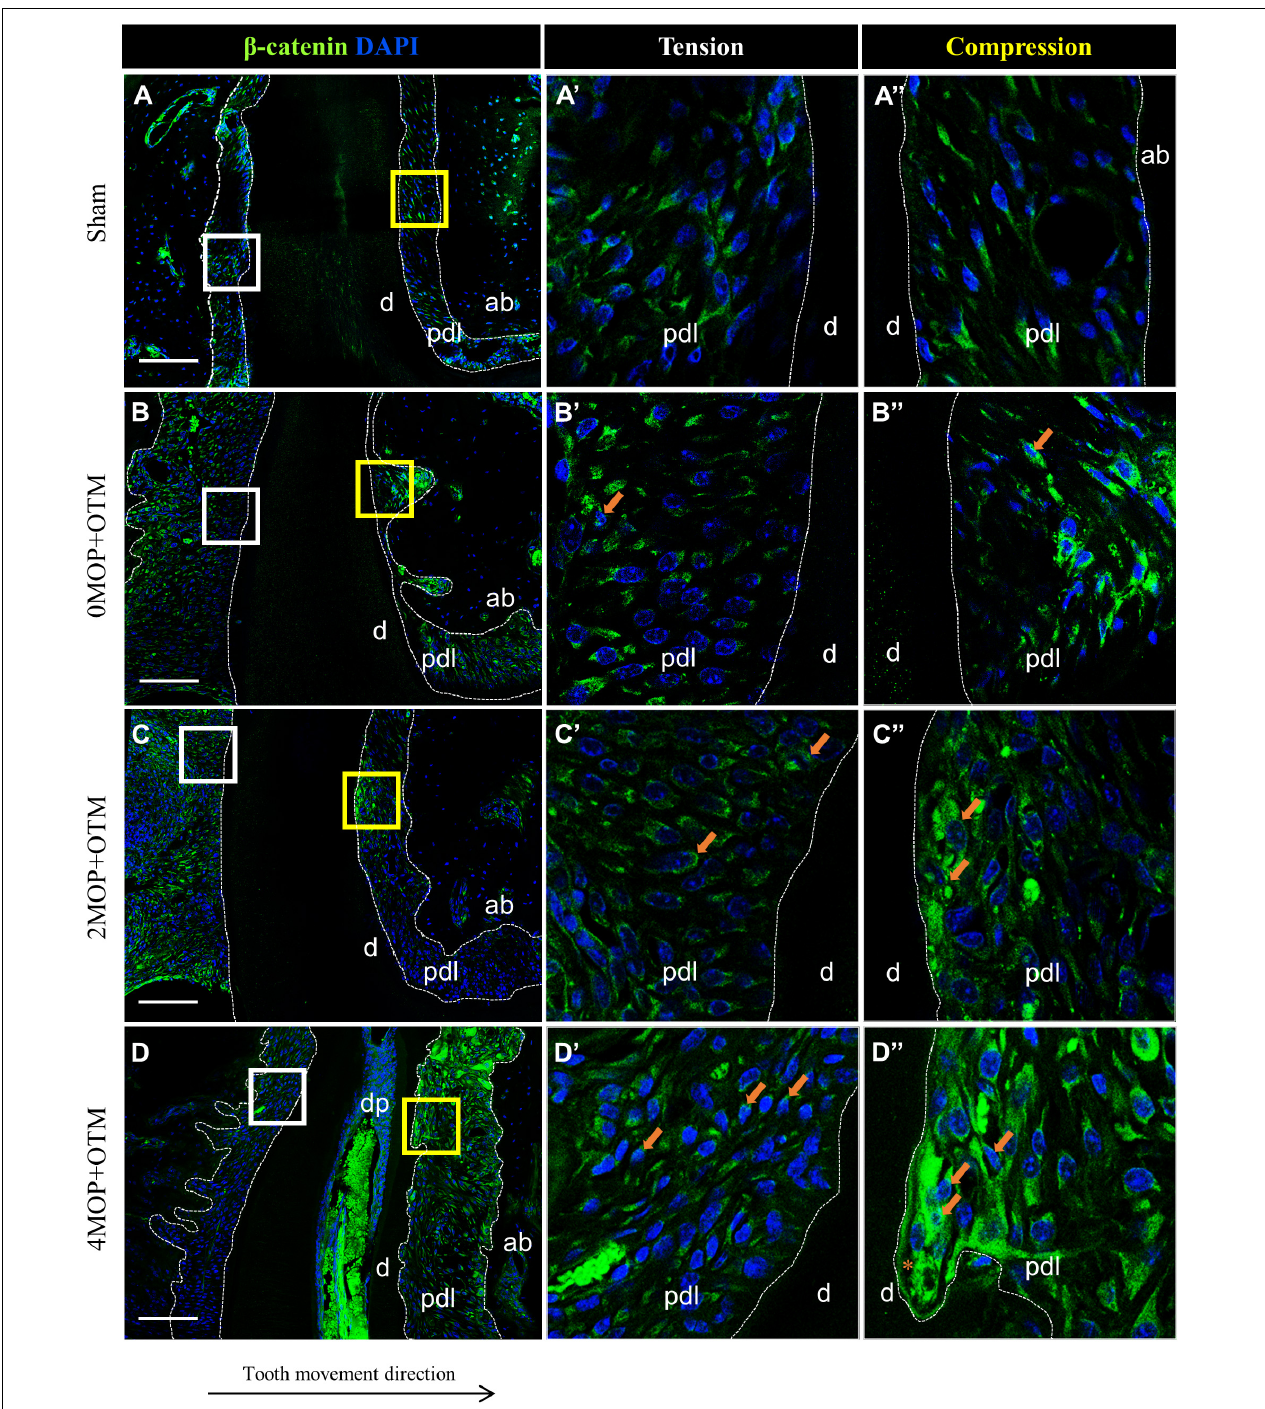
FIGURE 6 | Differential expression of Wnt/ β -catenin dependent to the number of MOP. (A) In sham group, Wnt/ β -catenin was evenly expressed in both sides of PDL. (A’) High magnification of tension side. (A”) High magnification of compression side of PDL. (B) β -catenin expression in 0MOP+OTM group. (B’) High magnification of tension side and (B”) Compression side. Relatively stronger expression of β -catenin ( arrow ) on both side of PDL than Sham group. (C) 2MOP+OTM group. (C’) The tension side was moderate increased. (C”) The compression side was slightly increased expression ( arrows ) than 0MOP+OTM group. (D) In 4MOP+OTM group, β -catenin expression was strongly increased compared to other groups. (D’) In tension side showed moderate to strong expression. (D”) In compression side, intensively strong expression of β -catenin was detected especially on root resorption area. (Dashed lines, outlines of PDL area; d, dentin; p, periodontal ligament; ab, alveolar bone; dp, dental pulp; asterisks ( ∗ ) indicate root resorption area; arrow, examples of single stained cells; Scale bars = 100 µ m).